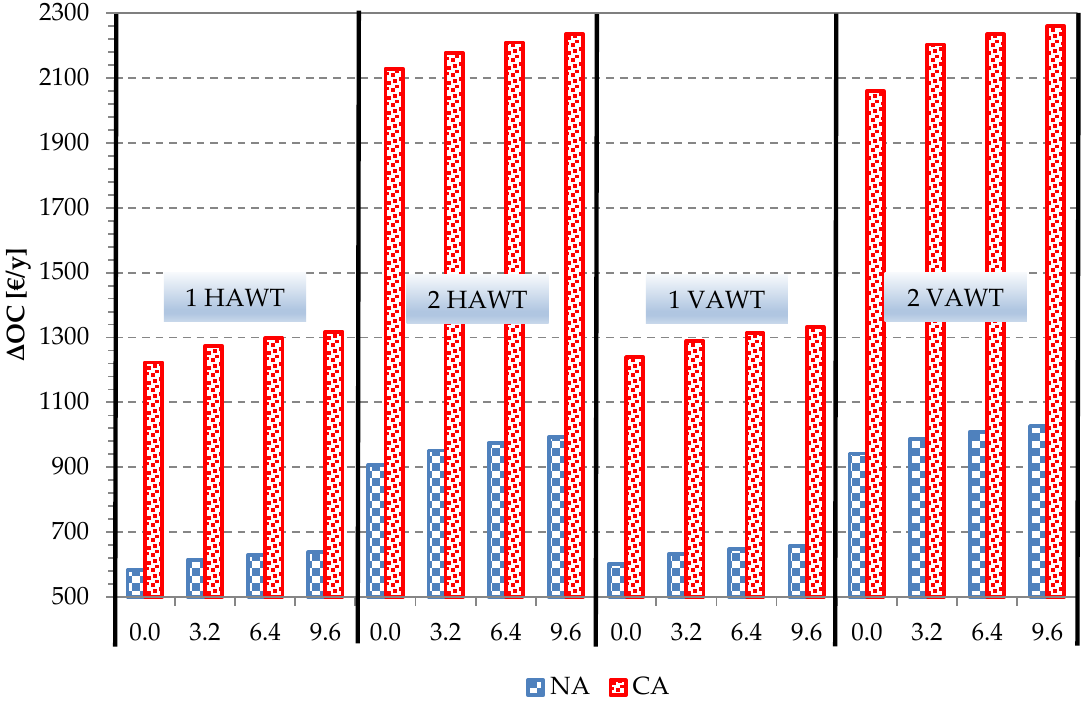
Figure 16. Operating cost reduction due to introduction of PS upon varying WT technology (HA, VA), number of WTs (one, two), battery size (0.0–9.6 kWh), and location (Naples, Cagliari).